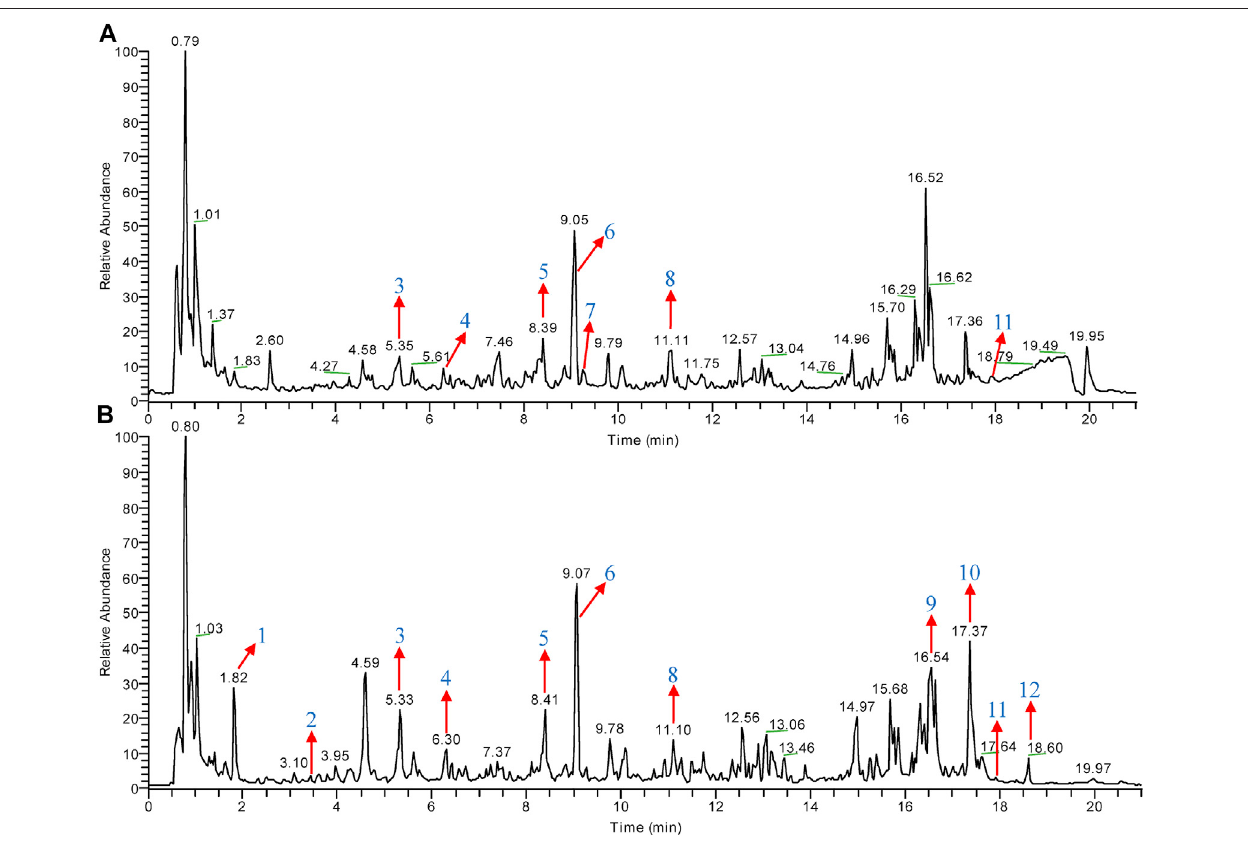
FIGURE 1 | Total ion chromatogram (TIC) of CHGX analyzed by UPLC-MS/MS. UPLC-MS/MS was used for the analysis of CHGX, and data were proceeded by Xcalibur 4.2 software. The positive ion (A) and negative ion (B) chromatograms of CHGX are shown as indicated. Major compounds of CHGX were as follows: 1 , Gallic acid; 2 , Protocatechuic acid; 3 , Catechin; 4 , Epicatechin; 5 , Liquiritin; 6 , Isoliquiritin; 7 , Coumarin; 8 , Ononin; 9 , Glycyrrhizic acid; 10 , Rheic acid; 11 , Pogostone; 12 , Emodin.